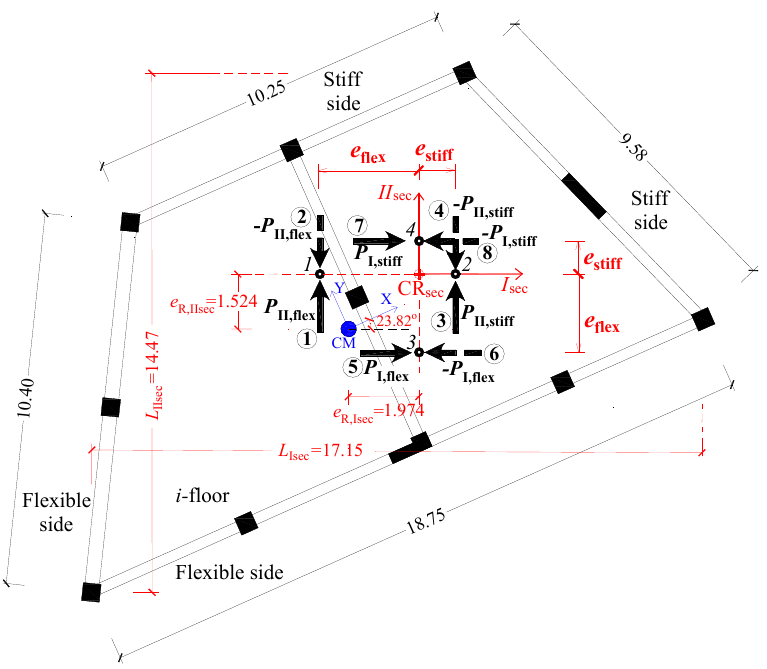
Figure 7. Eight (8) pushover analyses per pattern. The floor lateral static forces are applied at the positions determined by the inelastic dynamic eccentricities e flex and e stiff